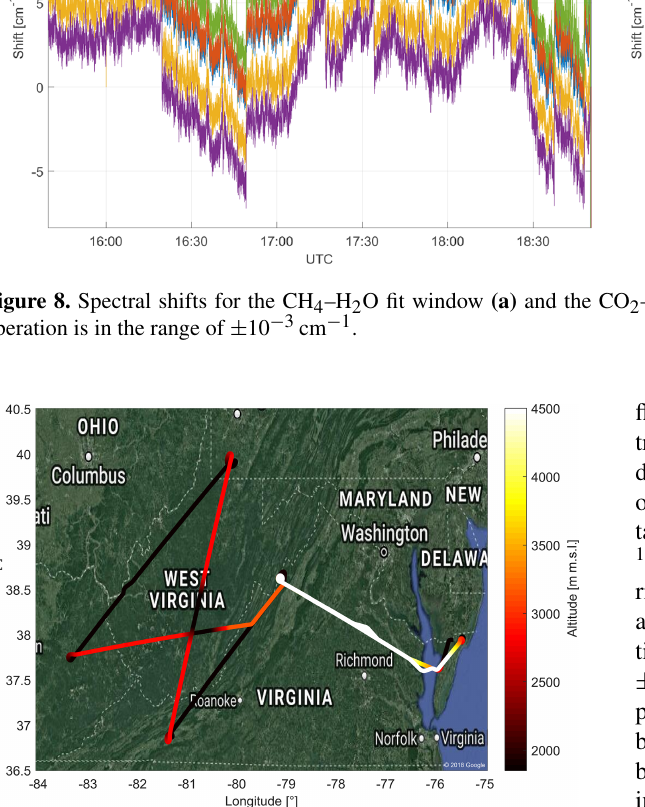
Figure 9. A typical flight during ACT-America. This figure shows the flight pattern for 3 October 2017 with color-coded altitude. The flight includes two low-altitude ( ≈ 300ma.g.l.) legs downwind and upwind of parts of the Marcellus shale area. High-altitude transects between the two low-altitude legs include two en route descents and ascents in West Virginia. Fair weather conditions and light southerly winds were present throughout the flight